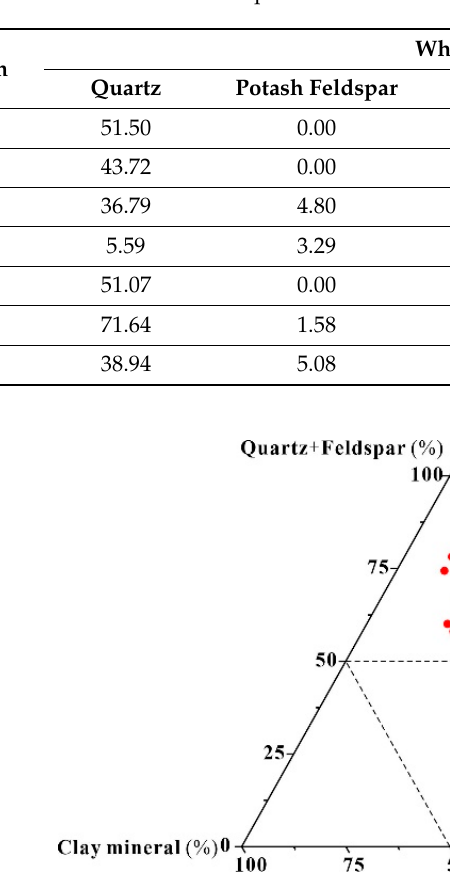
Figure 2. Shale sample mineralogical composition ternary diagram.